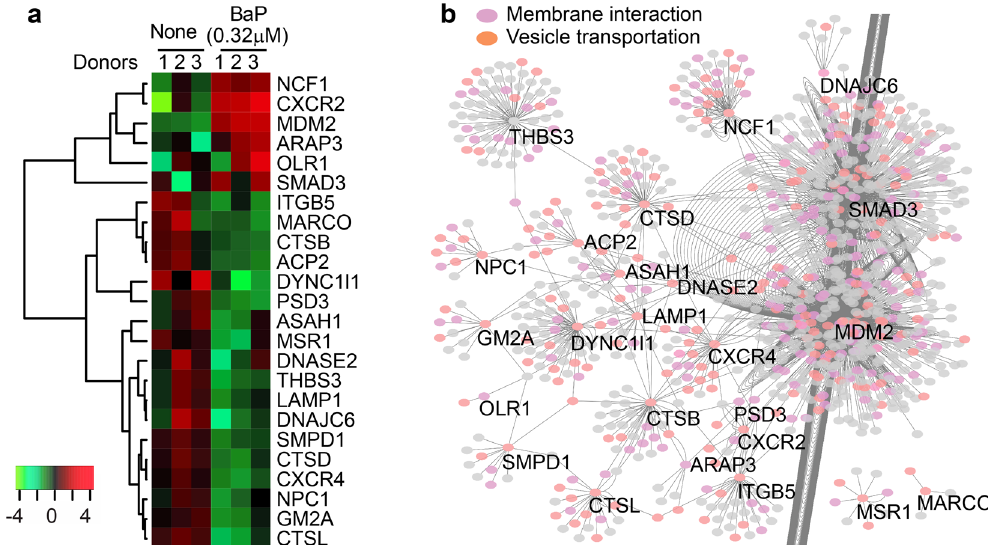
Figure 4. Gene expression and interaction of endocytic gene clusters. A heatmap shows the expression level of individual genes from endocytic clusters ( a ). The partner proteins interacting with these encoded proteins were predicted by searching against the protein interaction database BioGRID3.4 and visualized with Cytoscape. The result shows a putative interacting network highly relevant to membrane interactions and vesicle transportations ( b ). Each node represents a protein and each line represents an